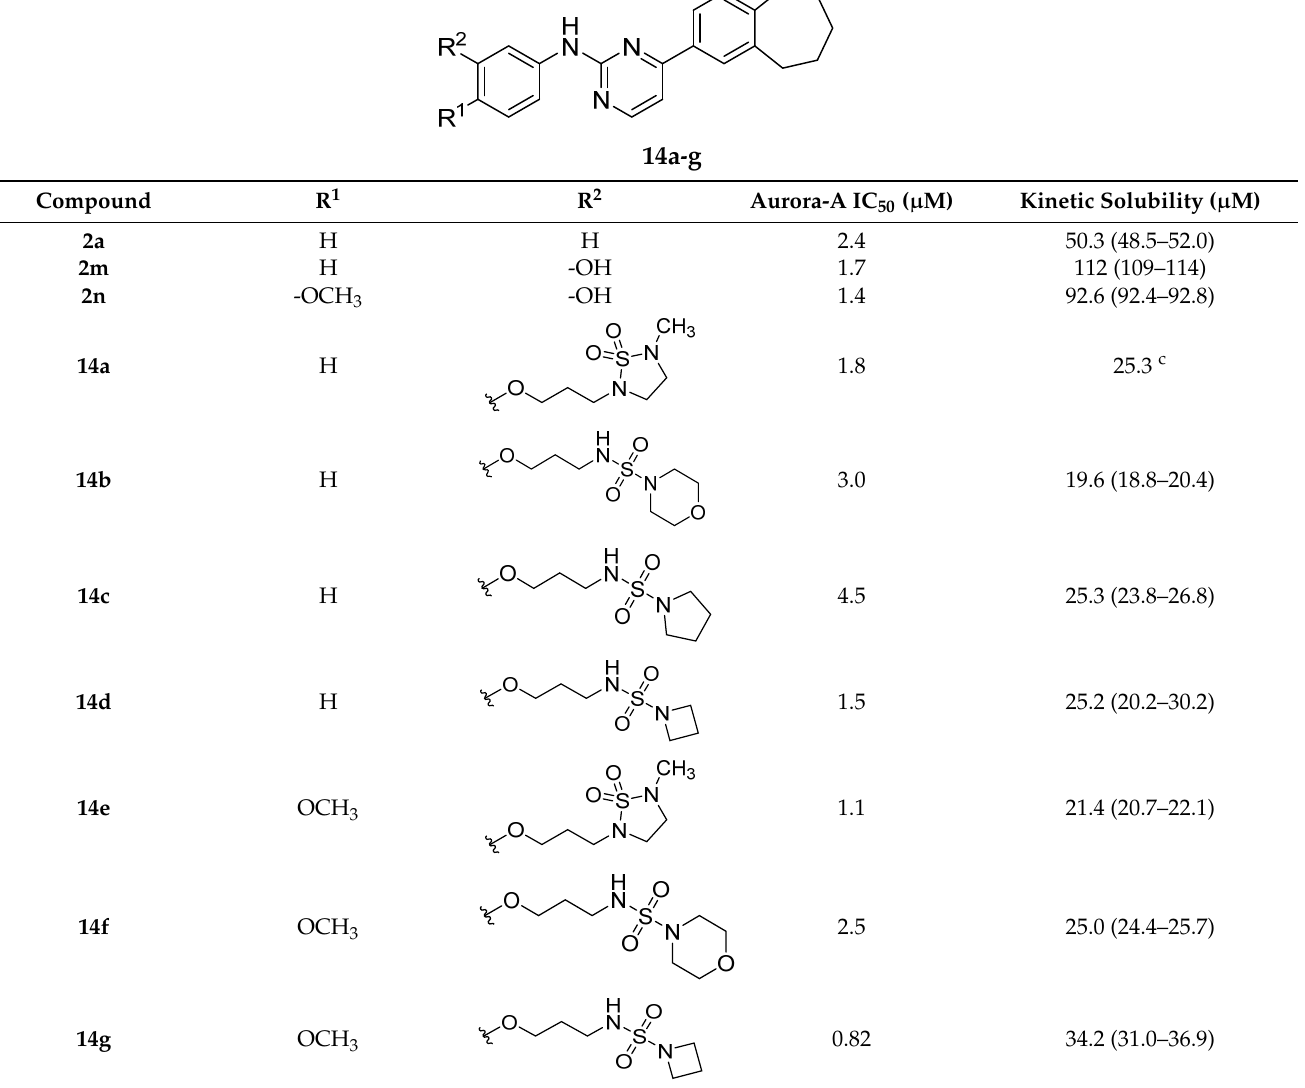
a As a measure of assay quality, the Z’-factor [26,27] was used. The Z’ factor in the test run with compounds 14a – 14g was 0.57, indicating a very good assay quality. Inhibition data for 2a taken compounds 14a – 14g was 0.57, indicating a very good assay quality. Inhibition data for 2a taken from Table 2 for comparison. b Determined by nephelometry as a mean of two measurements, compounds 14a – 14g was 0.57, indicating a very good assay quality. Inhibition data for 2a taken from Table 2 for comparison. b Determined by nephelometry as a mean of two measurements, compounds 14a – 14g was 0.57, indicating a very good assay quality. Inhibition data for 2a taken from Table 2 for comparison. b Determined by nephelometry as a mean of two measurements, from Table 2 for comparison. b Determined by nephelometry as a mean of two measurements, range given in brackets. c Singlicate measurement. from Table 2 for comparison. b Determined by nephelometry as a mean of two measurements, range given in brackets. c Singlicate measurement. range given in brackets. c Singlicate measurement. range given in brackets. c Singlicate measurement. range given in brackets. c Singlicate